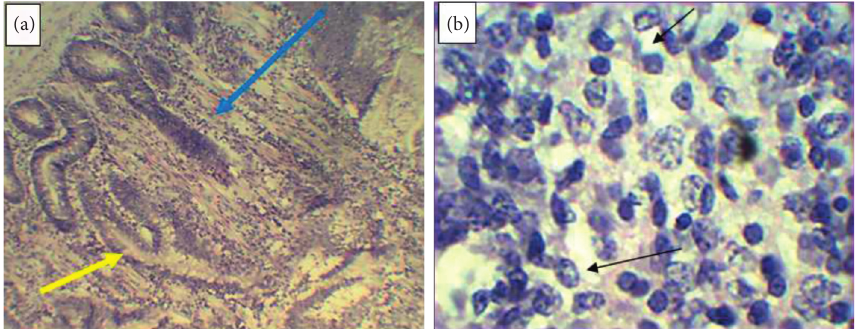
Figure 6: Tubercular granuloma on intestinal tissue (a) characterized by central necrosis indicated by the blue arrow and peripheral inflammatory cells shown by the yellow arrow and lymphoid depletion on the spleen (b) indicated by the black